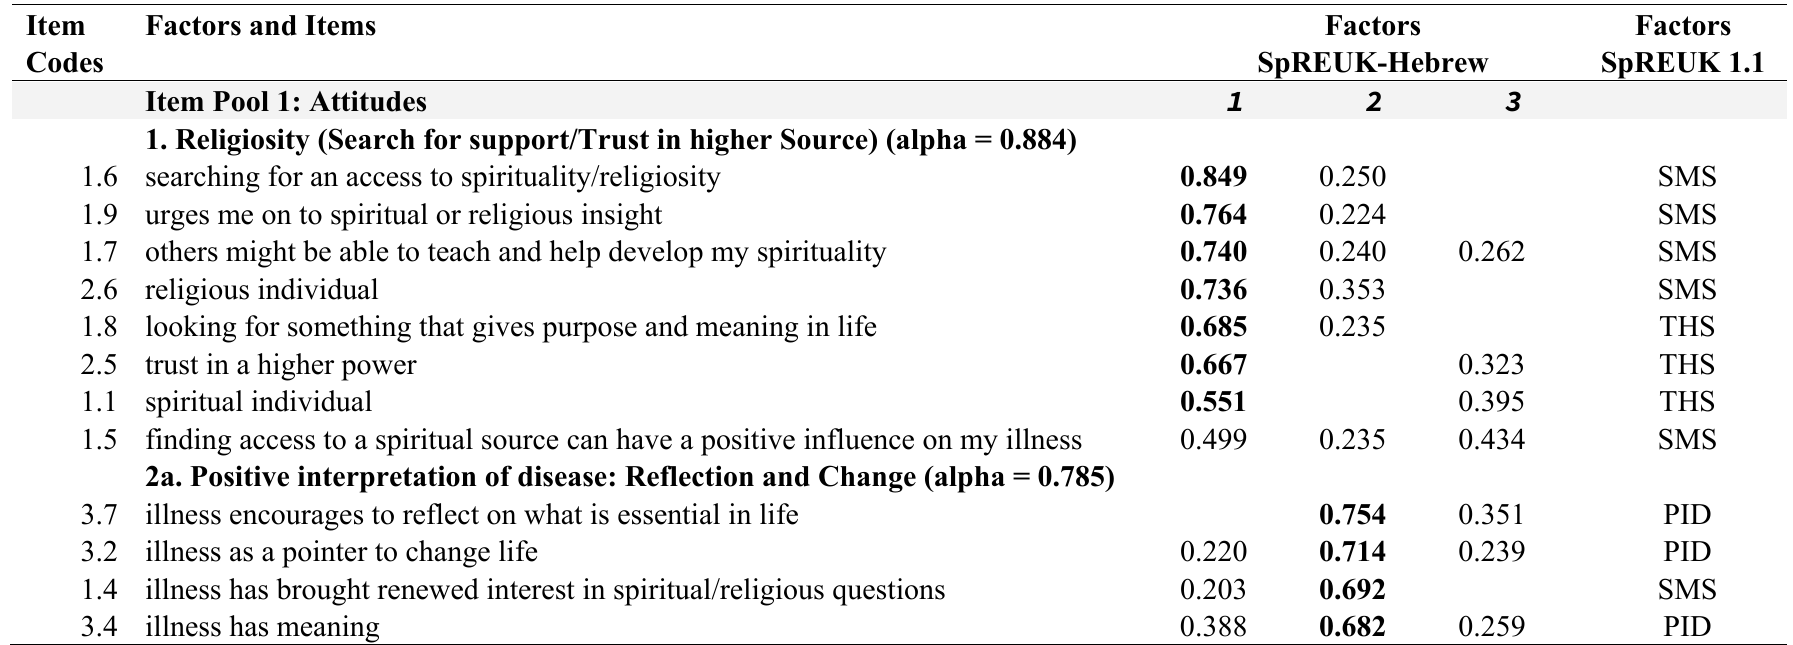
Table 3. Factorial structure of the